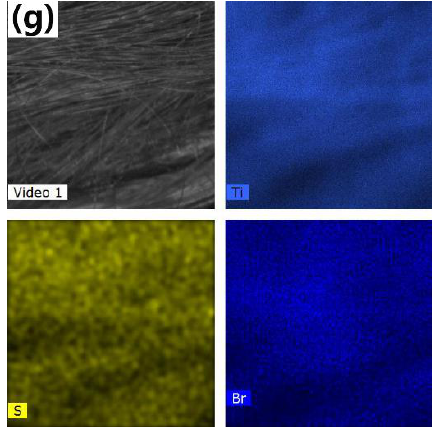
Figure 1. Field emission scanning electron microscope (FESEM) images of polyethylene terephthalate (PET) filaments for the ( a ) original, ( b ) and ( c ) S1–F, ( d ) and ( e ) S2–F; ( f ) X-ray diffraction (XRD) patterns of the as-prepared Titanium dioxide (TiO 2 ) powders; ( g ) the composition and homogeneity analysis of the S1–F.